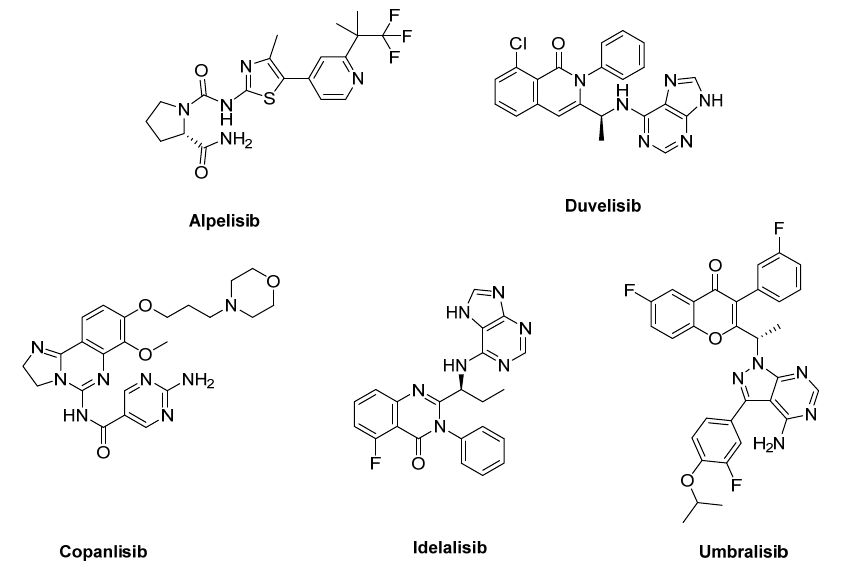
Figure 1. Structures of the PI3K inhibitors approved by the FDA.